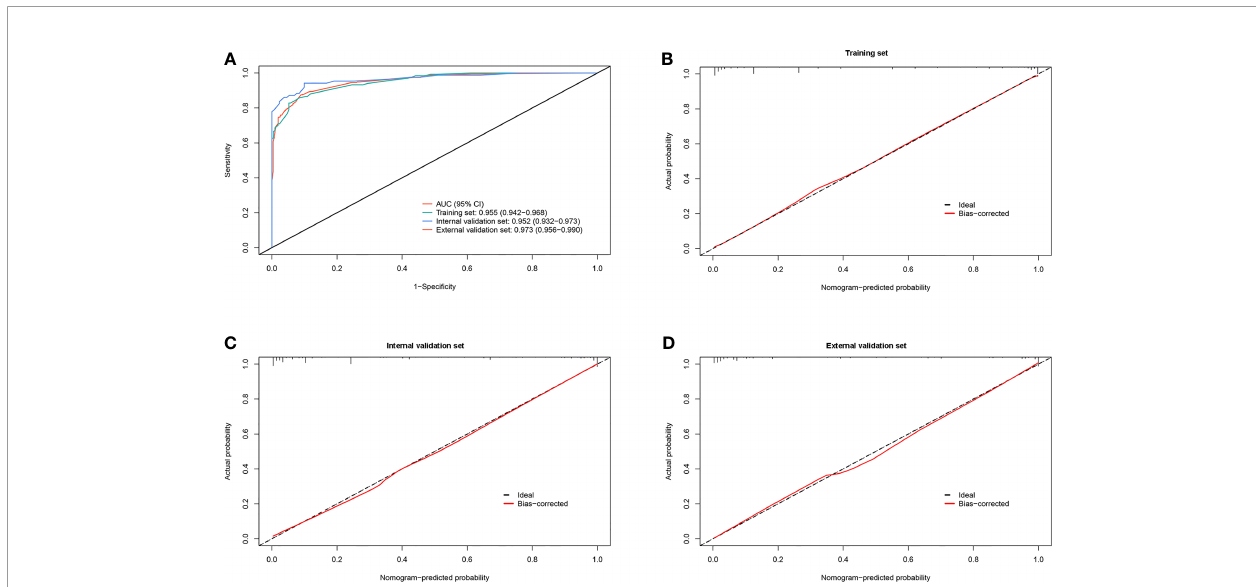
FIGURE 3 | Diagnostic ability and calibration of the scoring system for identifying malignant pleural effusion (MPE) from benign pleural effusion (BPE). (A) Plot showing the receiver operating characteristic (ROC) curves of the scoring system in the training, internal validation, and external validation sets. (B – D) Plots presenting the calibration curves of the scoring system in the training, internal validation, and external validation sets.